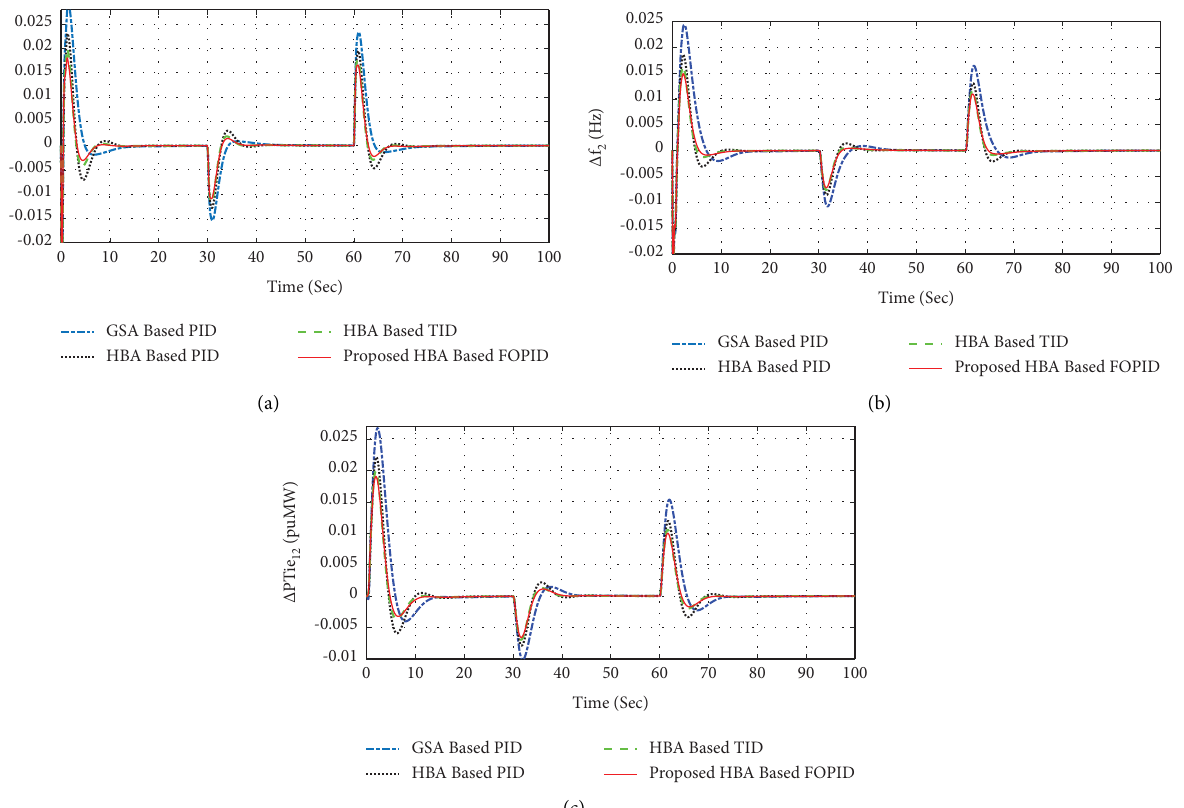
Figure 6: (a–c) System response for condition 2: (a) A